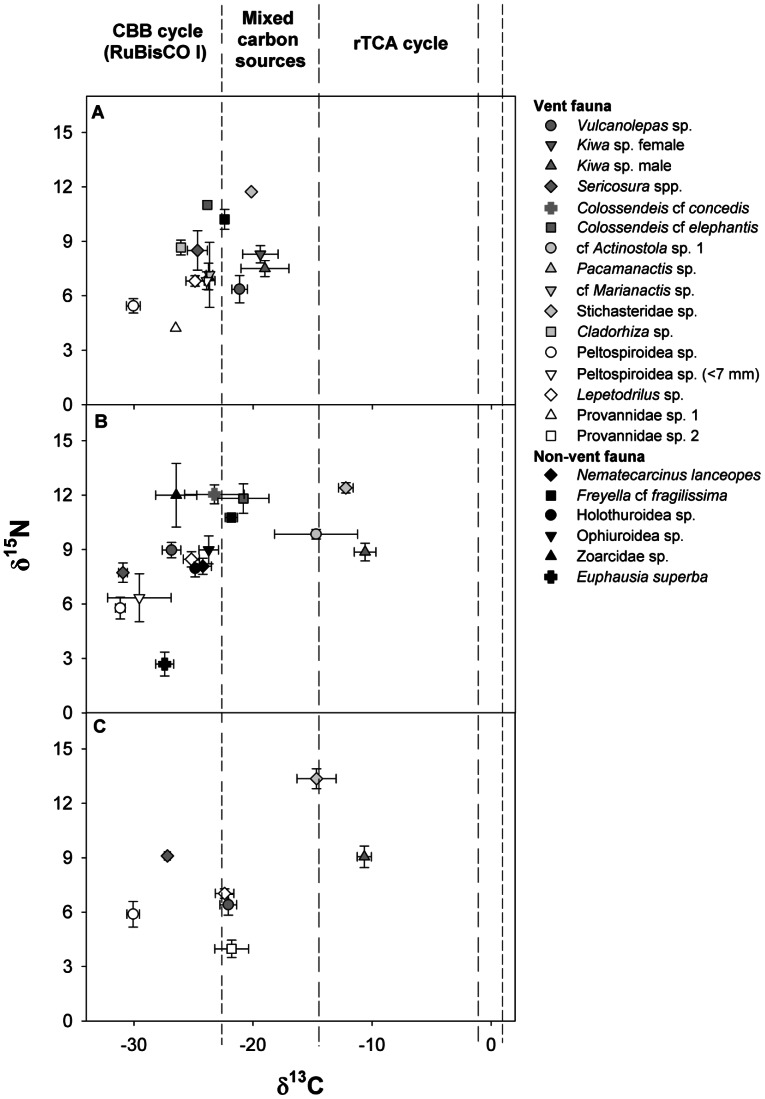
δ13C and δ15N values of macroconsumers collected from the East Scotia Ridge, Southern Ocean.The values represent means (± standard deviations) for hydrothermal vent and non-vent macroconsumers from the three sample sites: (a) E2, (b) E9N and (c) E9S. Dashed vertical lines represent potential ranges of δ13C values indicative of carbon sources sustaining macroconsumers at the ESR: triple dashed line represents the Calvin-Benson-Bassham (CBB) cycle utilising form I RuBisCO, double dashed line represents the reductive tricarboxylic acid (rTCA) cycle, mixed carbon sources occur between the triple and double dashed line and the continuous dashed line represents the approximate δ13C values of the dissolved inorganic carbon from the diffuse flow areas.